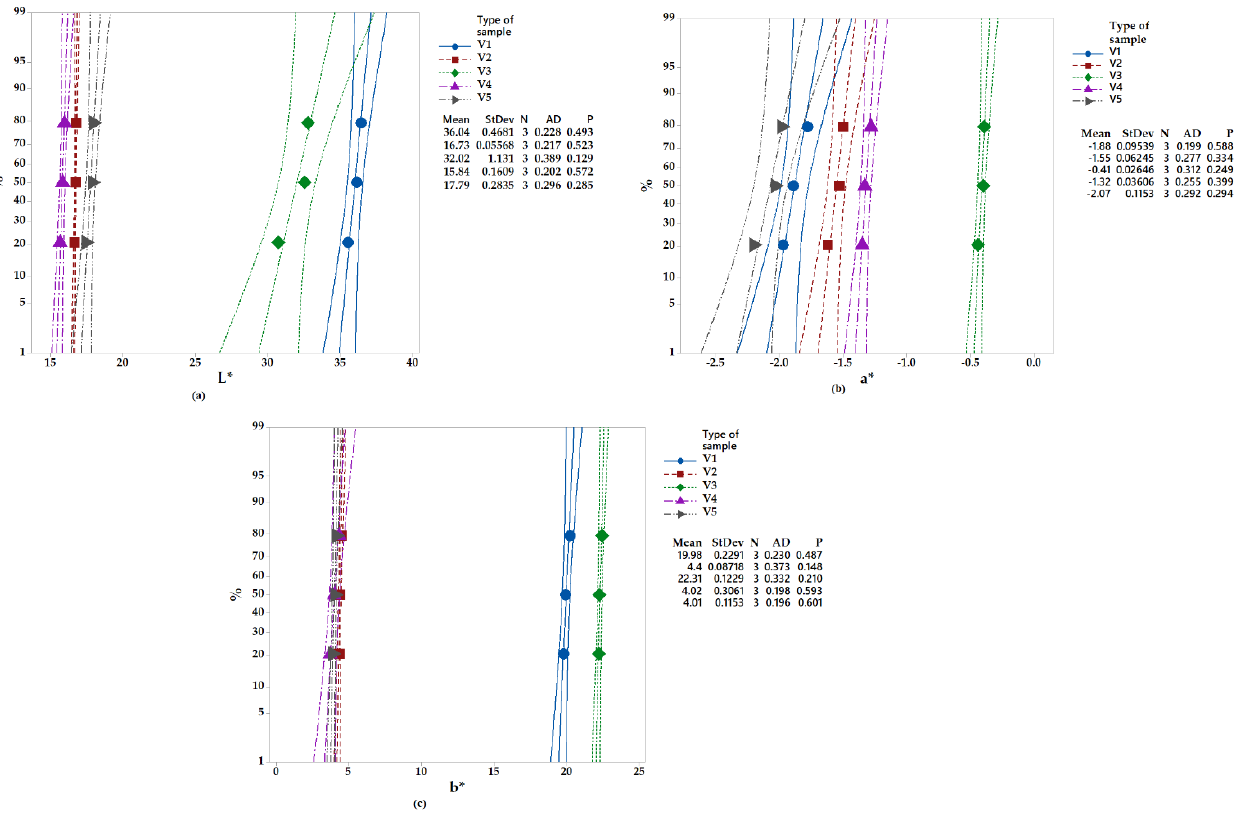
Figure 1. Color parameters of the banana peels and commercial balsamic vinegars: ( a ) L*; ( b ) a*; ( c ) b*. p -values are equal to 0.000, which means that the color parameters are statistically significant. Results obtained by applying Tukey pairwise comparisons method showed